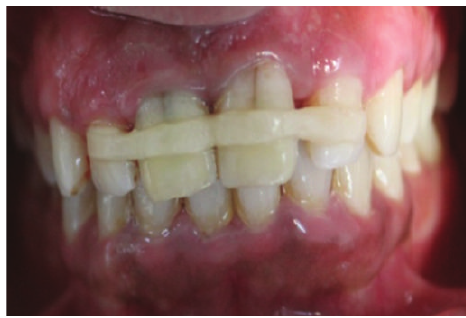
Figure 10: Flap reflection.